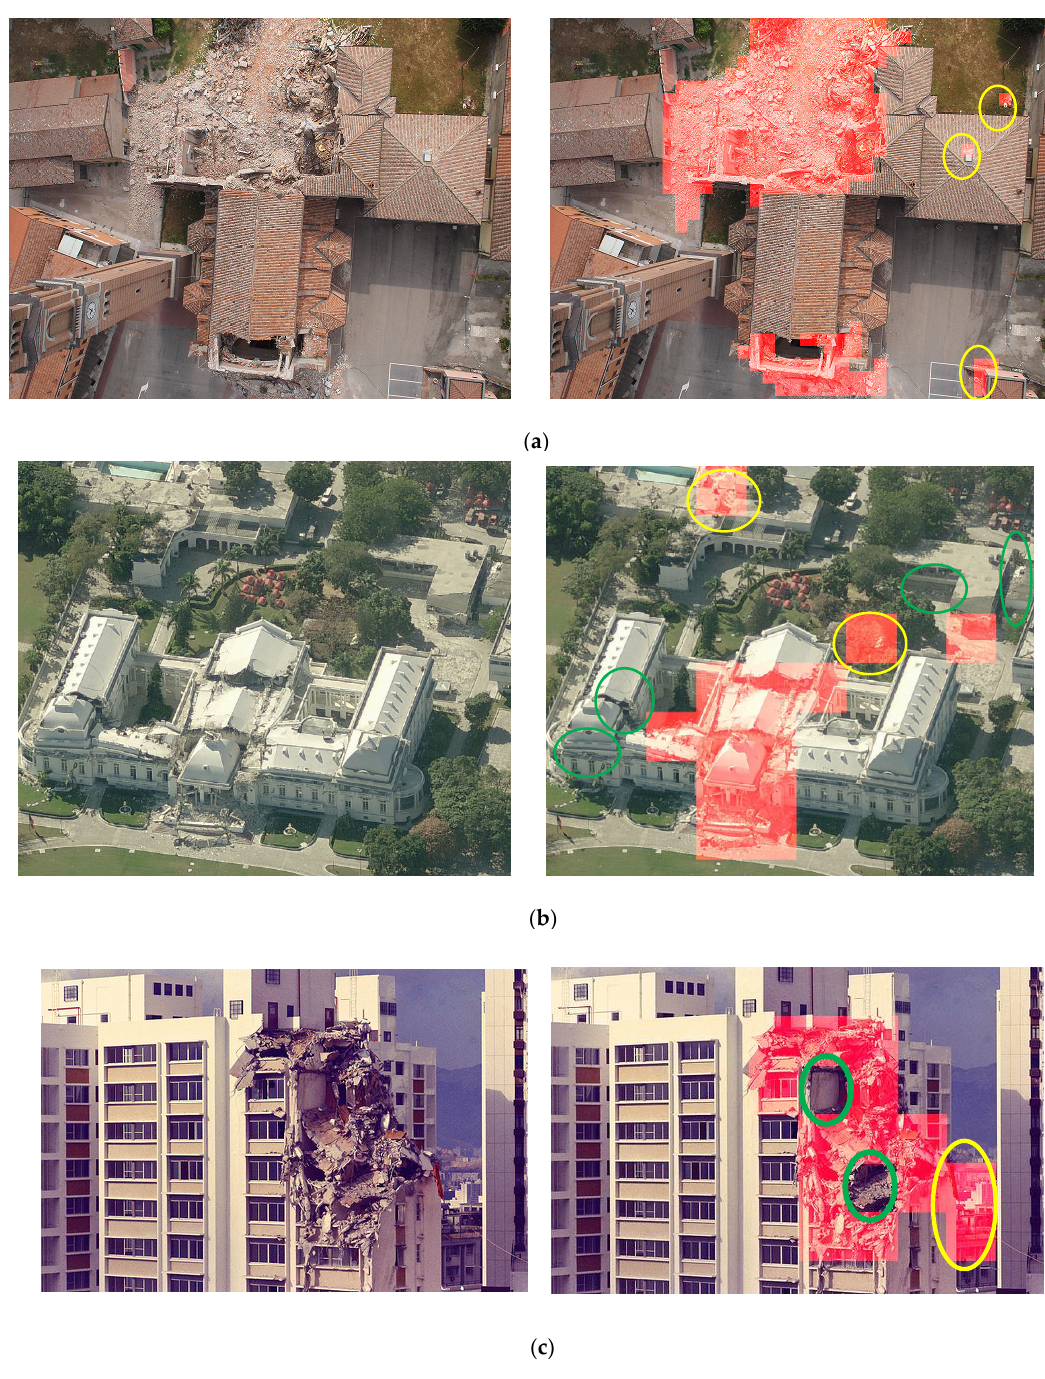
Figure 7. Damage classification of images based on best performing supervised model: ( a ) UAV image of dataset 1 ( left ); detected damaged regions are highlighted in red, and the false positives are highlighted using yellow circles ( right ); ( b ) Subset of Pictometry image of dataset 2 ( left ); detected damaged regions are highlighted in red, and the false positives and false negatives are highlighted using yellow and green circles, respectively ( right ). Images © Pictometry; ( c ) Street view image of dataset 3 ( left ); detected damaged regions are highlighted in red, and the false positives and false negatives are highlighted using yellow and green circles, respectively ( right ).